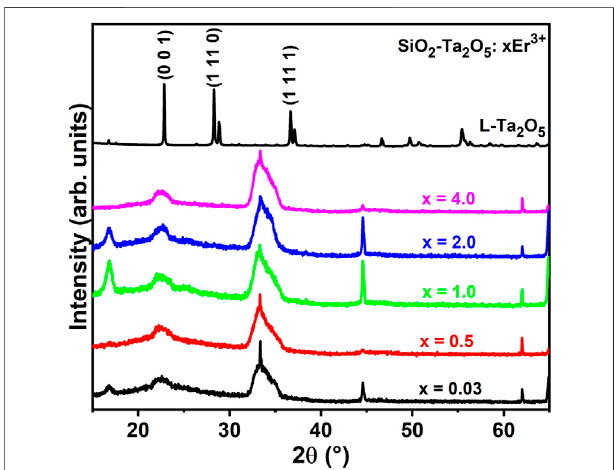
Frontiers in Chemistry |